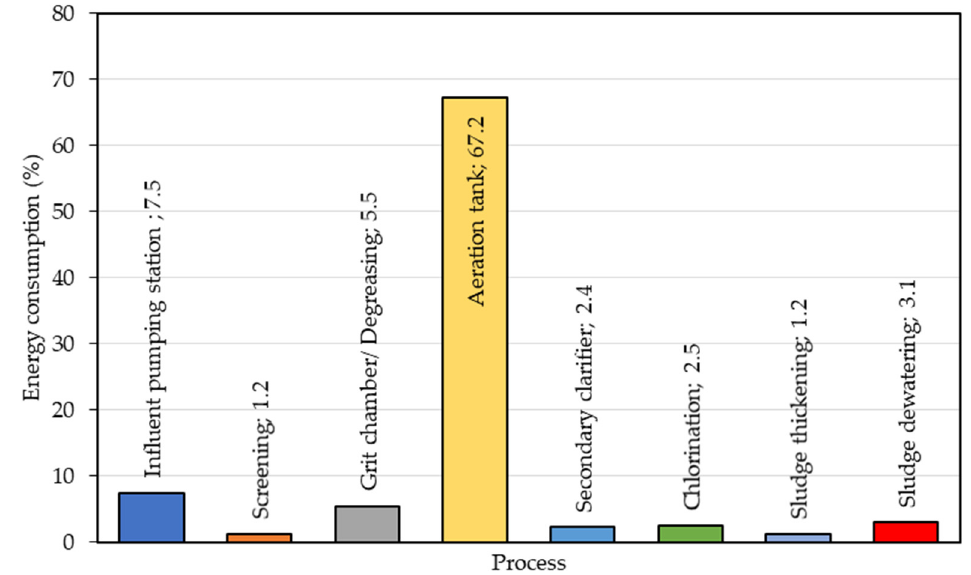
Figure 11. Energy distribution in the main processes of conventional activated sludge systems (influent pumping station; screening; grit chamber/degreasing; aeration tank; secondary clarifier; chlorination; sludge thickening; sludge dewatering).